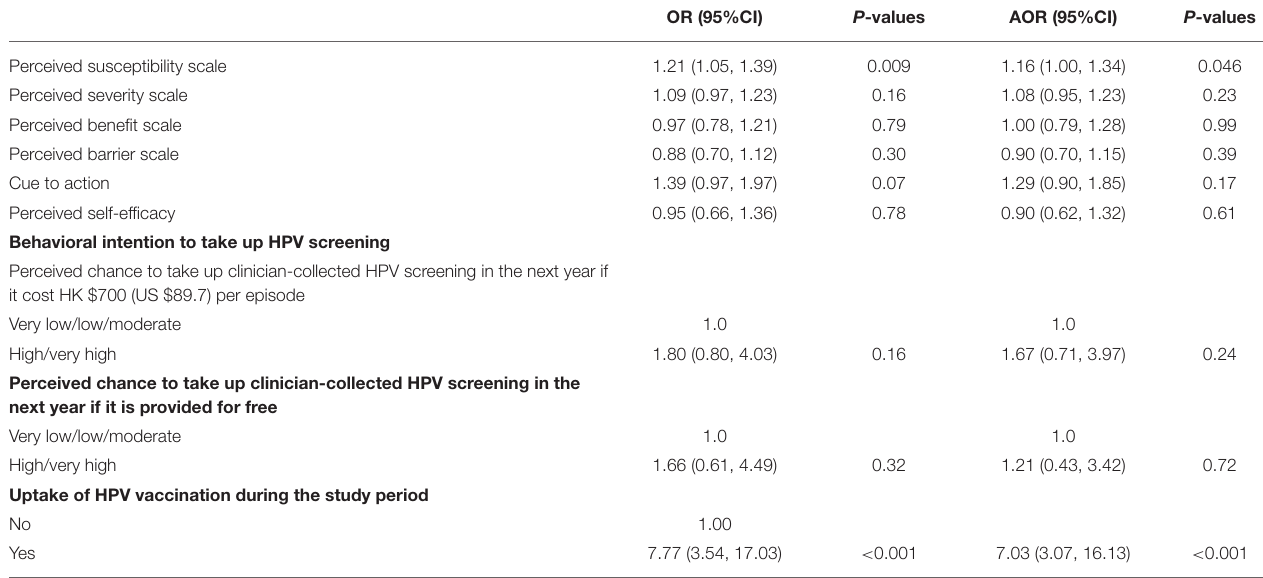
TABLE 3 | Associations between perceptions related to HPV screening (in general) and HPV vaccination with the uptake of HPV screening (among participants who completed Month 12 follow-up, n =